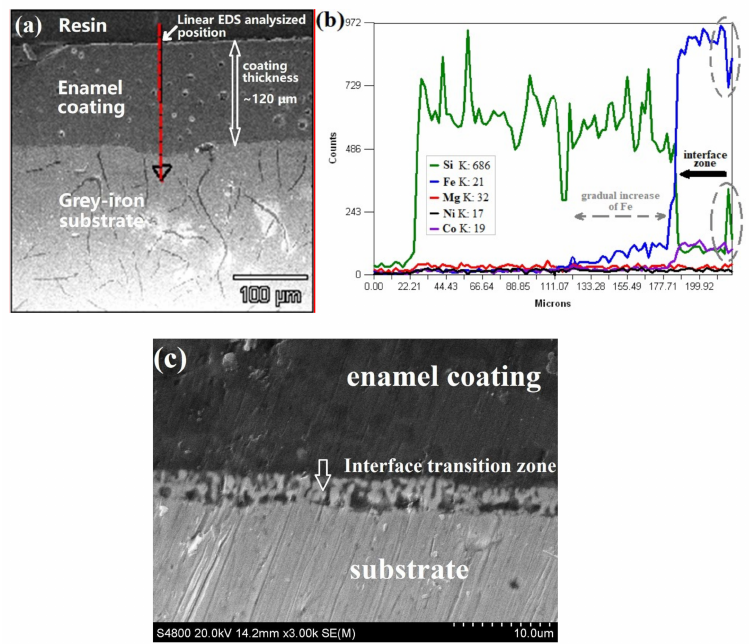
Figure 7. SEM morphologies ( a ) and linear energy dispersive x-ray spectrometer (EDS) analysis ( b ) of the cross-sectional view of the enamel coating, and the coating/substrate interface morphologies ( c